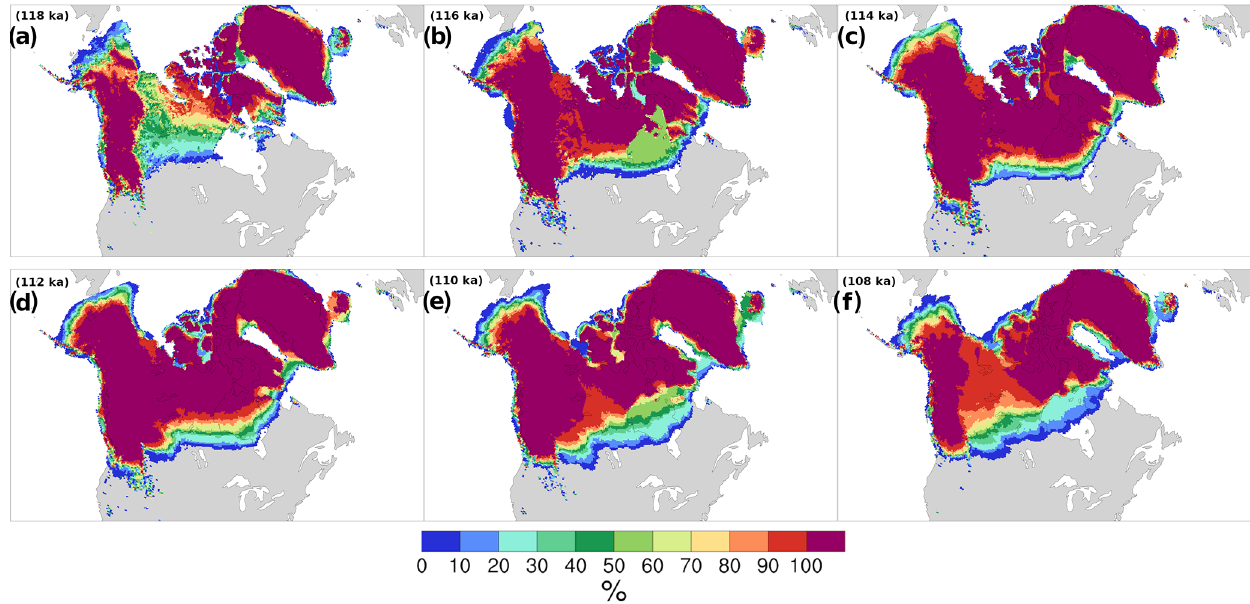
Figure 6. NA ice extent ensemble probability distribution at (a) 118ka, (b) 116ka, (c) 114ka, (d) 112ka, (e) 110ka, and (f) 108ka. The 118 and 116ka distributions are included to provide the history before the peak and are not discussed.